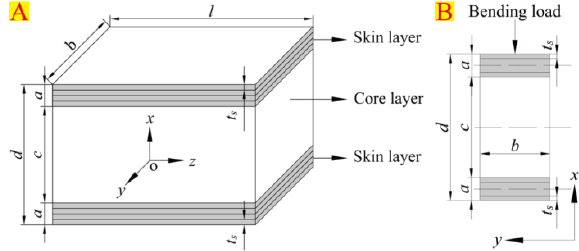
Figure 2. General model of sandwich structure: ( A ) in three dimensions; ( B ) in the z -direction.